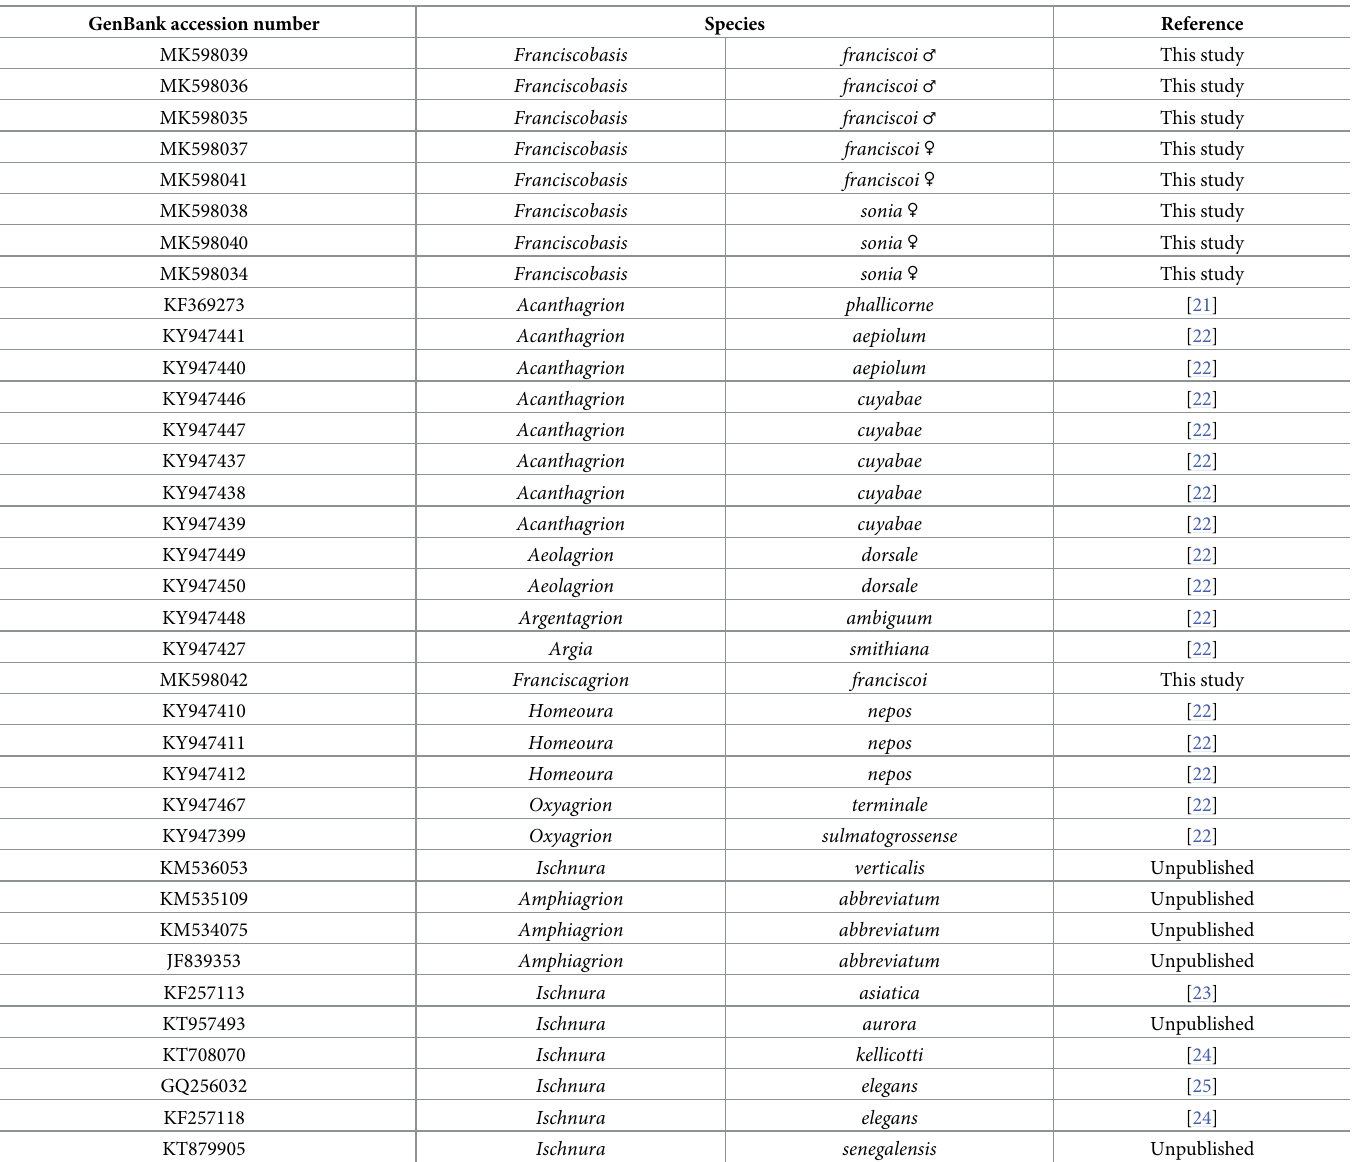
Table 1. List of sequences from GenBank used in this study (COI). ♂ : male specimens; ♀ : female